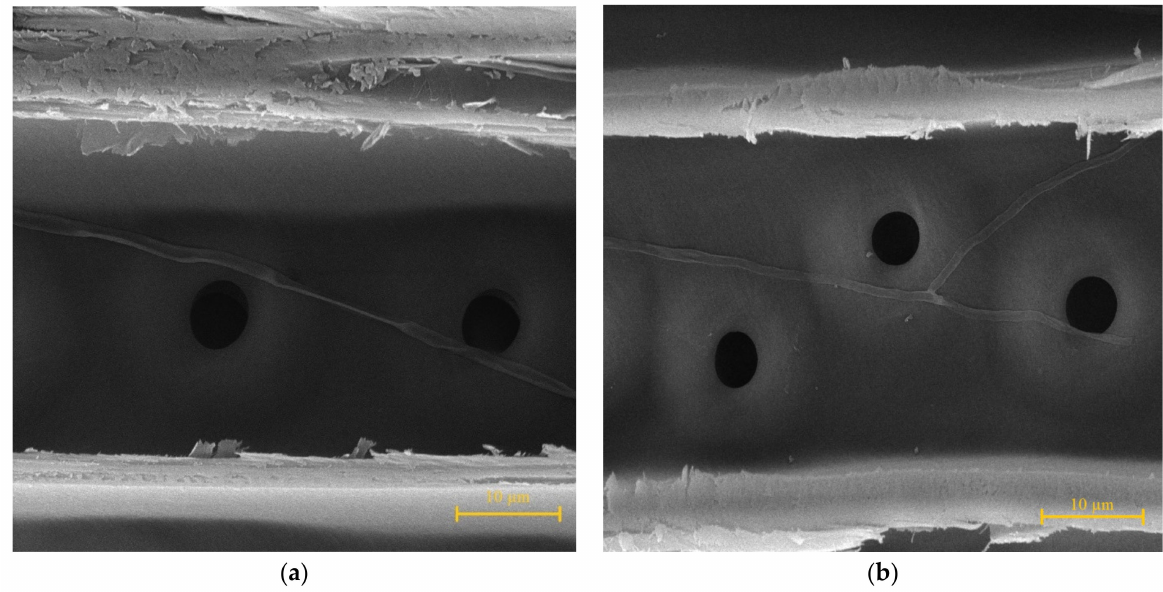
Figure 4. Fungal hyphae in the cell wall lumina of bark beetle-attacked Norway spruce xylem: ( a ) a sample from the part where fungal infestation was not visually observed; ( b ) a sample from the part where fungal infestation was visually observed (own